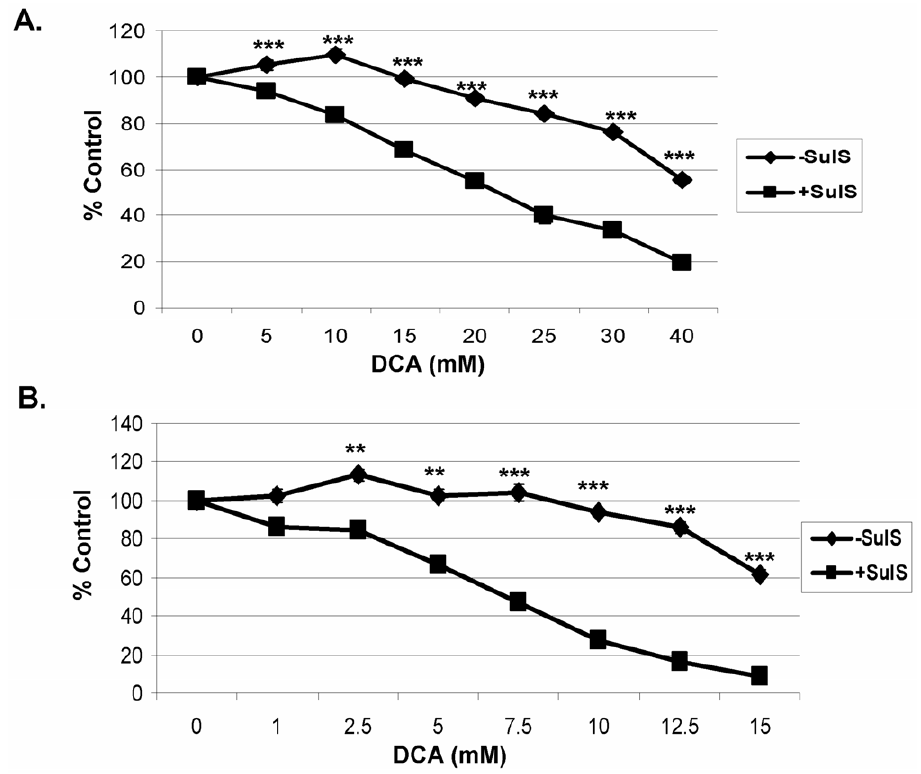
Figure 2. Sulindac sulfone in combination with DCA also kills cancer cells. The A549 and SCC25 cancer cells were treated with the indicated concentrations of DCA in the presence or absence of sulindac sulfone (SulS) for 48 hours. SulS was used at a final concentration of 250 m M for A549 cancer cells and 75 m M for SCC25 cancer cells. The cell viability was monitored by MTS assay as described in Methods. The cell viability is expressed as % of control (cells not treated with sulindac sulfone). Error bars are standard error of the mean (SEM) expressed as % of the mean value of triplicates from a representative experiment. Cell viabilities are illustrated for A549 cancer cells (A) and SCC25 cancer cells (B). ¤ , -SulS; & , + SulS. * p , 0.05, ** p , 0.005, ***p ,